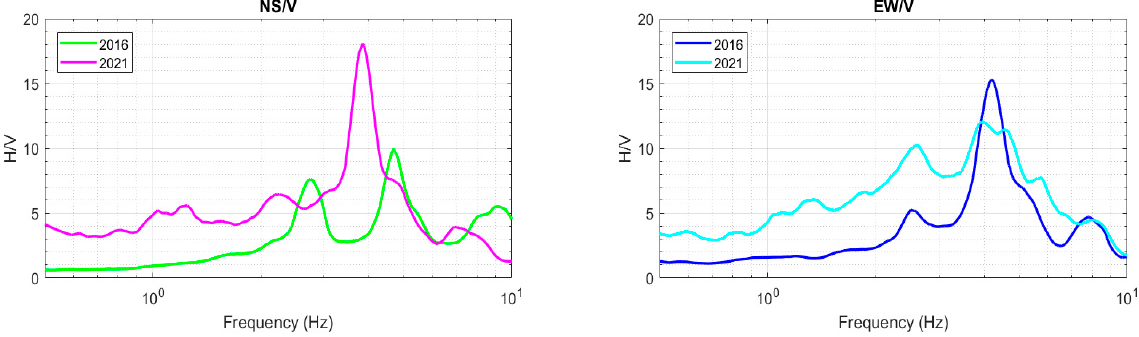
Figure 8. Comparison between ambient noise measurements carried out in 2016 and 2021 on the Castle’s 2nd floor, position 2.